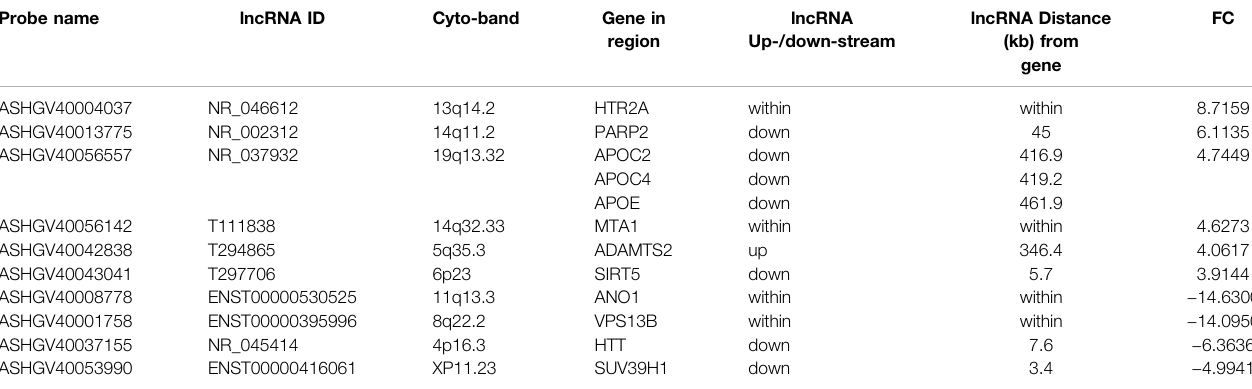
TABLE 3 | Up and downregulated lncRNAs and proximity to putative stroke